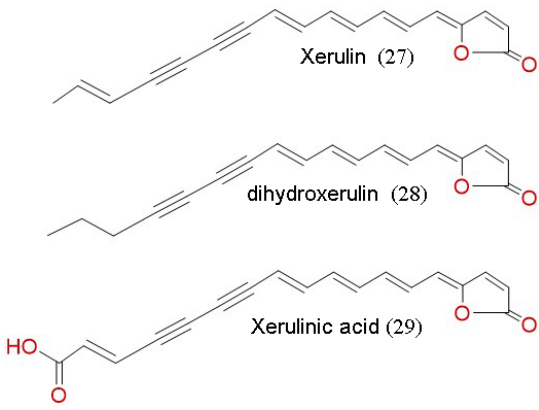
Figure 8. Chemical structures of other compounds act as inhibitors of cholesterol biosynthesis iso- lated from Oudemansiella melanotricha.